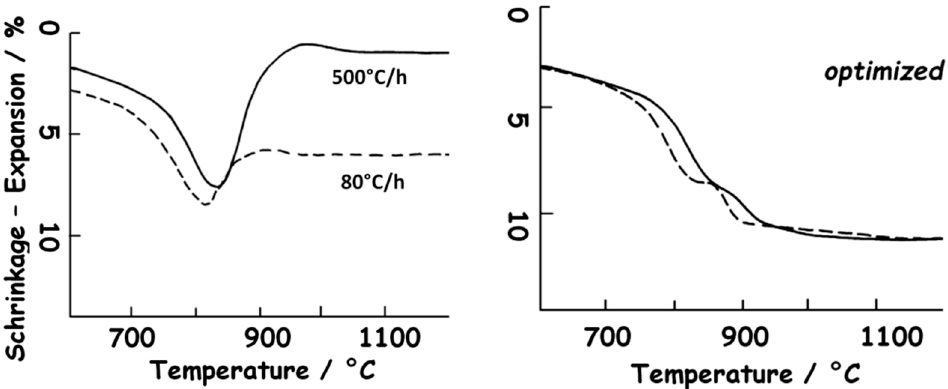
Figure 4. Dilatometric plots of Li 2 O · 2 Al 2 O 3 · 4 SiO 2 (LAS) xerogel into a dense glass ceramic measured for the same composition prepared by different routes, for two heating rates (after [107]).